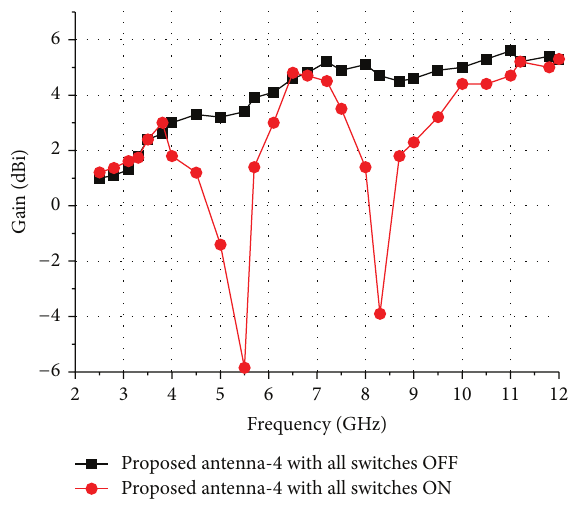
Figure 9: Gain of the fabricated